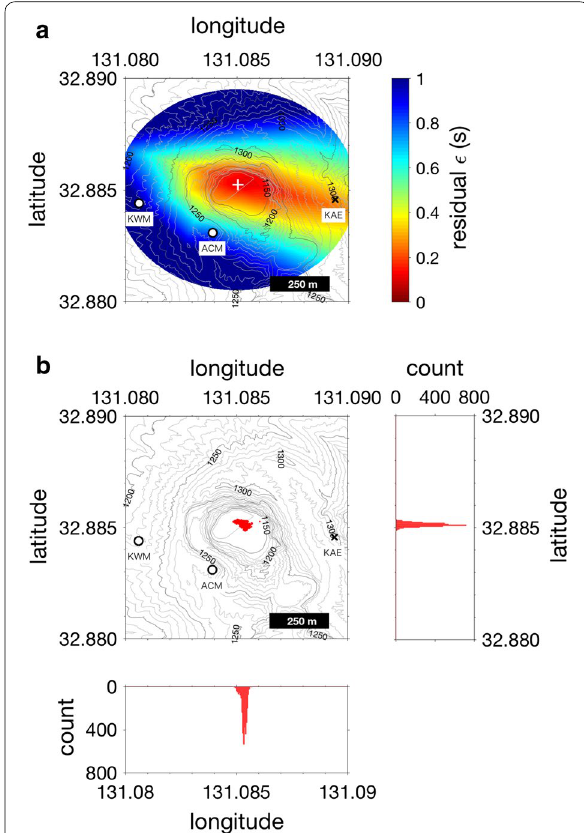
Fig. 7 Source location of monochromatic infrasound waves. a Spatial distribution of the timing residual ǫ for 10-min data during 13:30–13:40 on December 15, 2015. White cross at the crater center shows a location with the minimum value ( ǫ = 0.10 s). b Source location of the 10-min infrasound records during the entire eruption period ( N = 3115